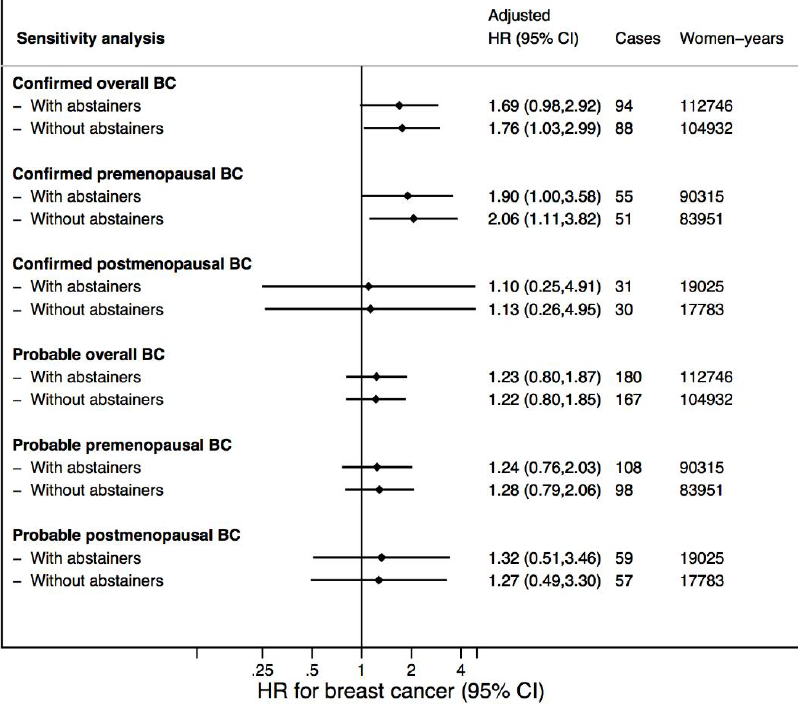
Figure 2. Sensitivity analyses showing Hazard Ratio (95% CI) of breast cancer—overall and stratified for menopausal status—with and without abstainers.